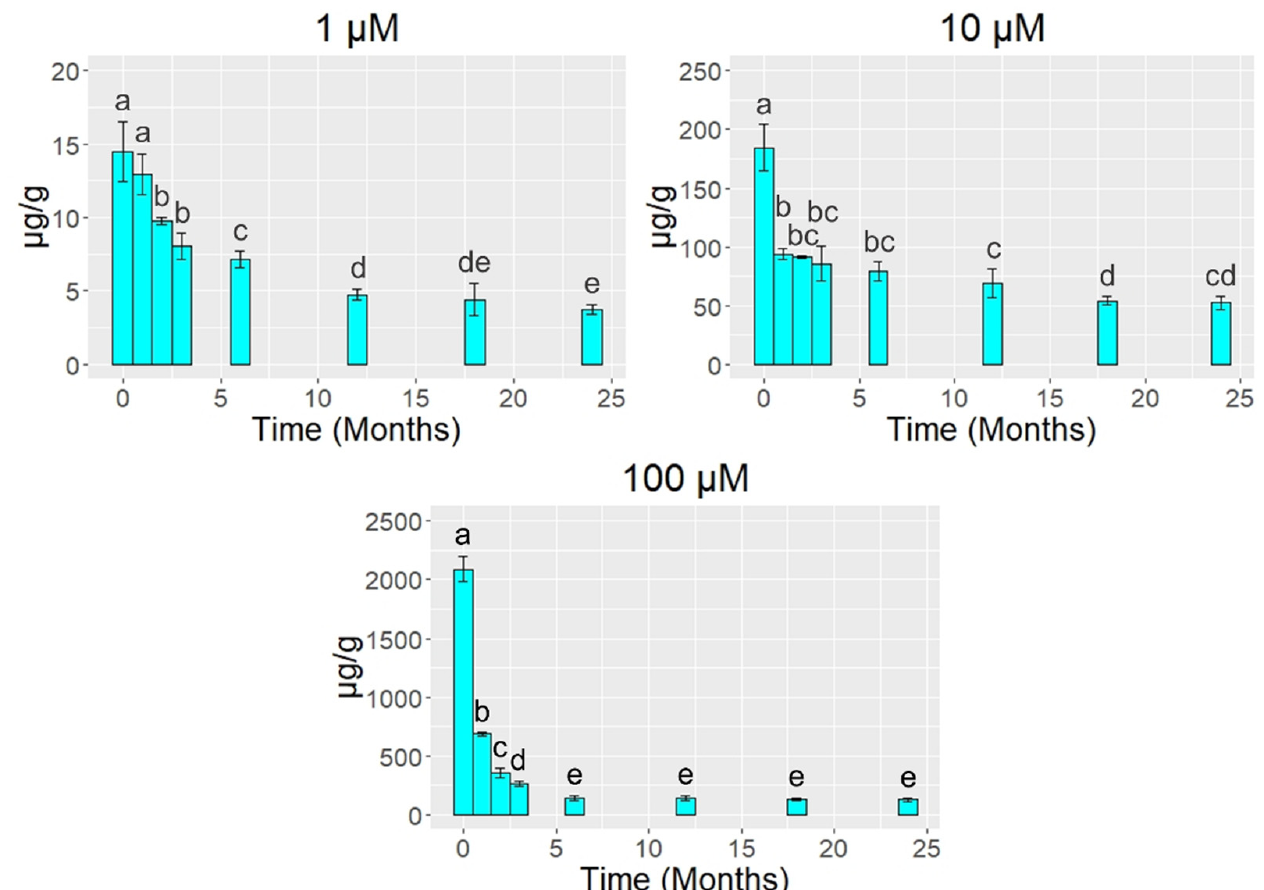
Figure 2. Linear regression between the content of Hg in the treatment solutions and in the lichen Evernia prunastri . Gray area = 95% confidence interval.